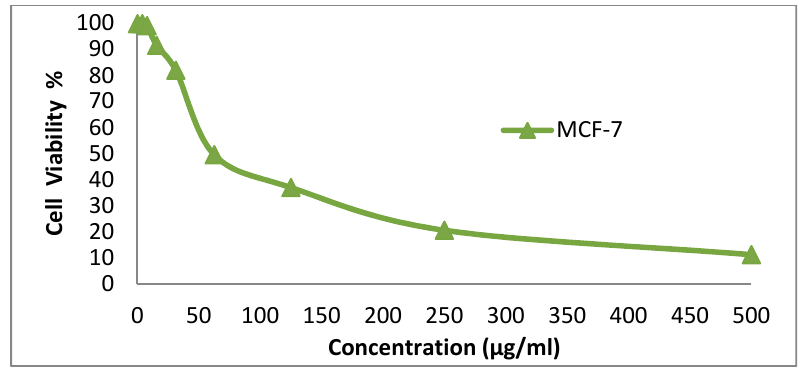
Figure 4. Evaluation of disperse dye 14x on cell line MCF-7.